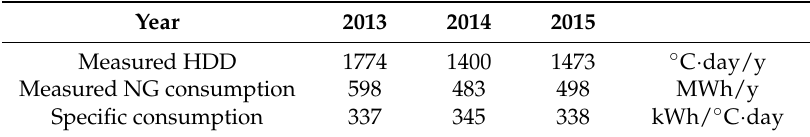
Table 1. Heating degree days (HDD) and natural gas (NG) consumption of the school over the selected